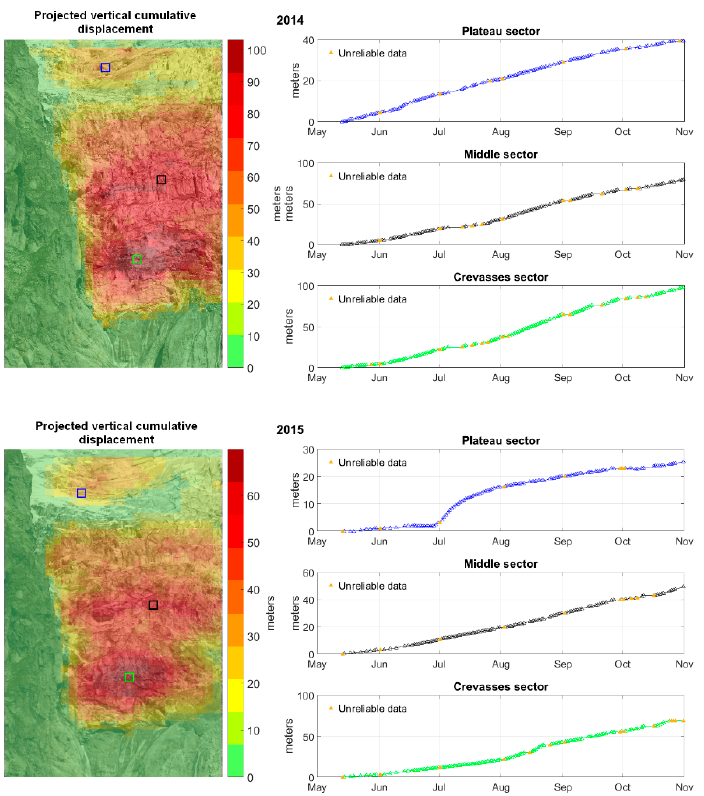
Figure 10. Projected vertical cumulative displacement maps for 2014 and 2015 and time series of displacement of different sectors. From the comparison one can note the behaviour changes and anomalies during time and space and identifies critical data.